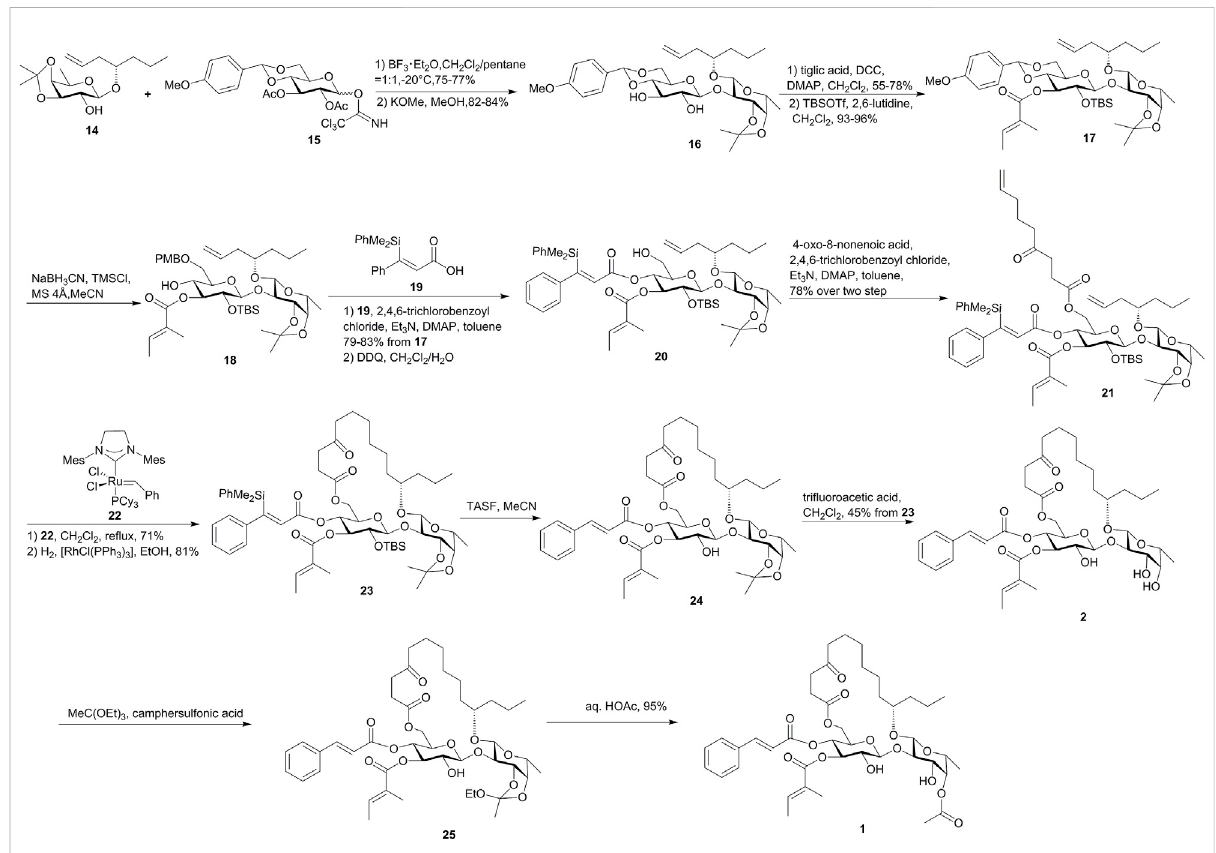
FIGURE 2 Fürstner ’ s approach toward the synthesis of ipomoeassins A – F ( 1 – 6 ). TASF, tris(dimethylamino)sulfonium di fl